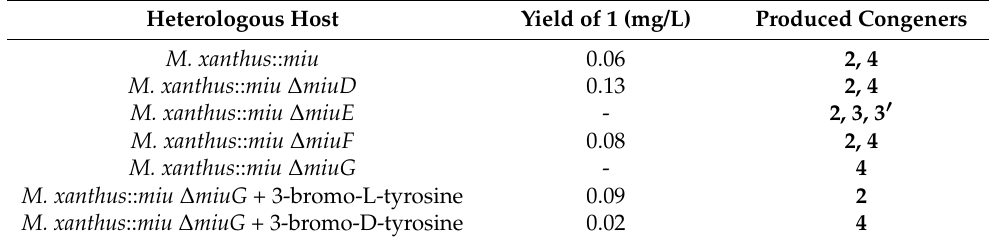
Table 2. Production of miuraenamide A ( 1 ) and its congeners in heterologous mutants lacking miuD–G . Heterologous Host Yield of 1 (mg/L) Produced Congeners M. xanthus :: miu 0.06 2, 4 M. xanthus :: miu ∆ miuD